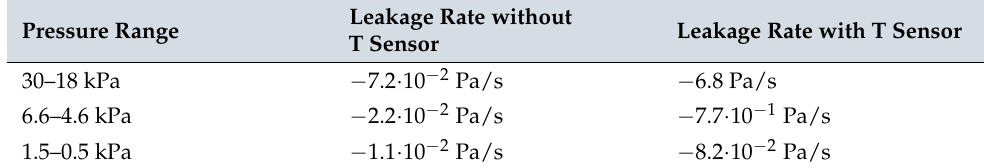
Figure 9. ( a ) Chamber leakage as a function of time without temperature PDMS feed-through. ( b ) Chamber leakage with temperature feed-through plugged on the chamber lid. Table 2. Leakage rates of the chamber with and without temperature sensor feed-through.